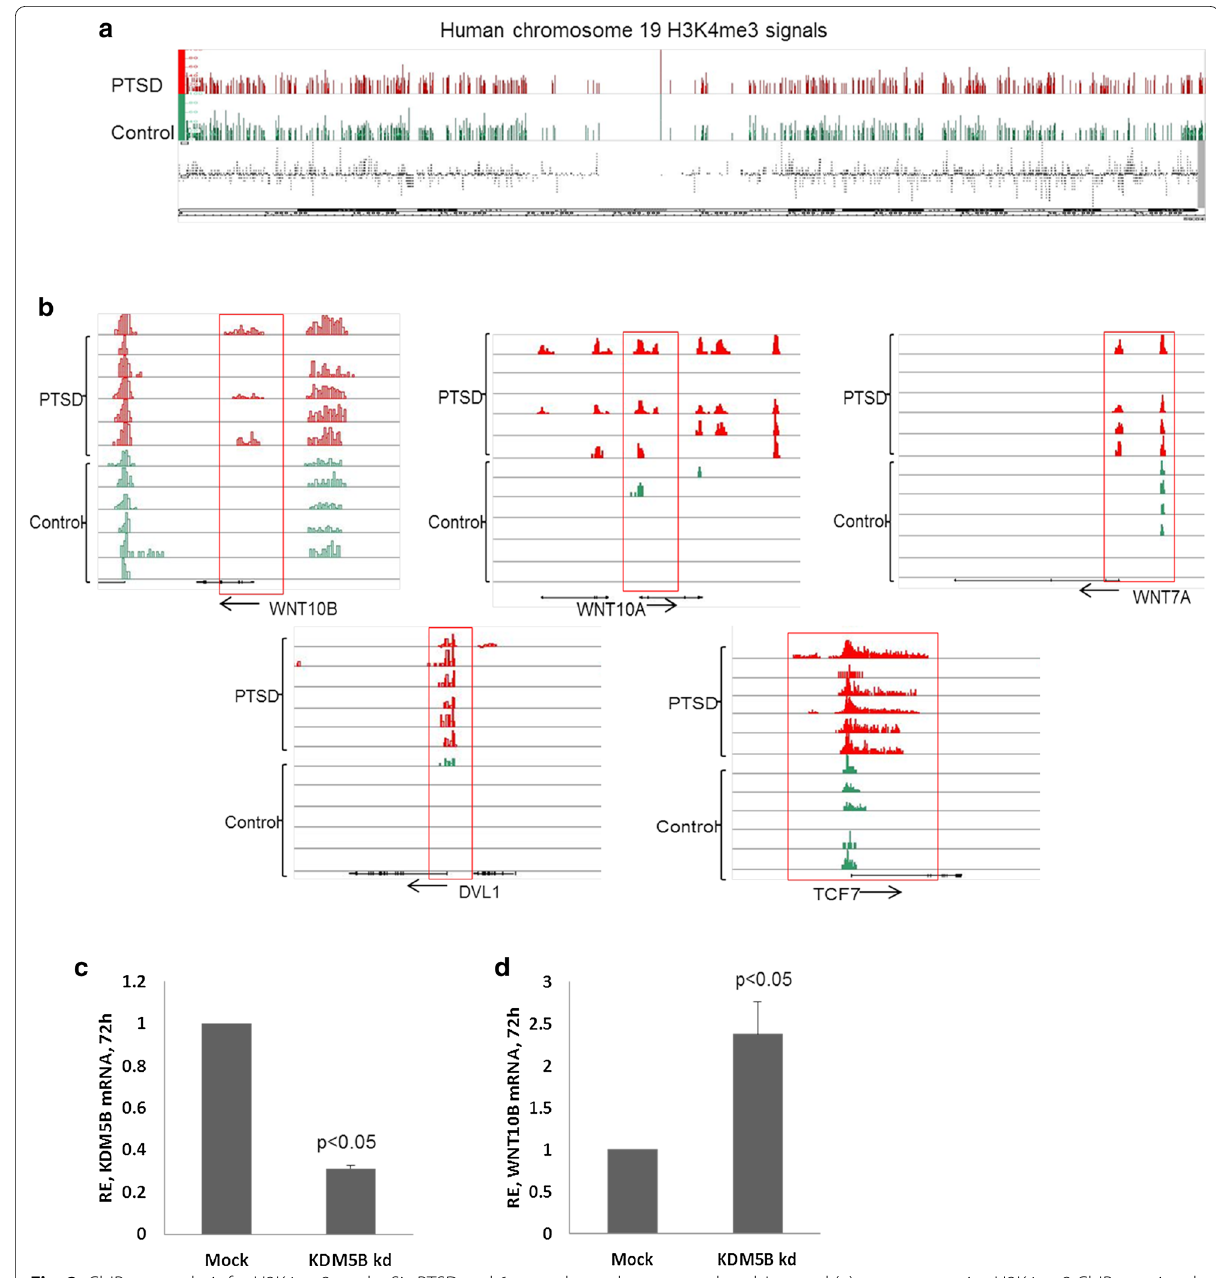
Fig. 2 ChIP-seq analysis for H3K4me3 marks. Six PTSD and 6 control samples were analyzed. In panel ( a ), a representative H3K4me3 ChIP-seq signal obtained after visualization of the sequencing data in Integrated Genome Browser (IGB) for human chromosome 19 is shown. b H3K4me3 signal around 5 genes of the WNT signaling pathway in 6 controls and 6 PTSD samples. One horizontal line represents a sample. c KDM5B was knocked down by siRNA in THP1 cells and confirmed by qRT-PCR after 72 h. The bar graph shows level of KDM5B transcripts in siRNA transfected cells. d WNT10B transcript level in KDM5B knocked down cells after 72 h. ( RE relative